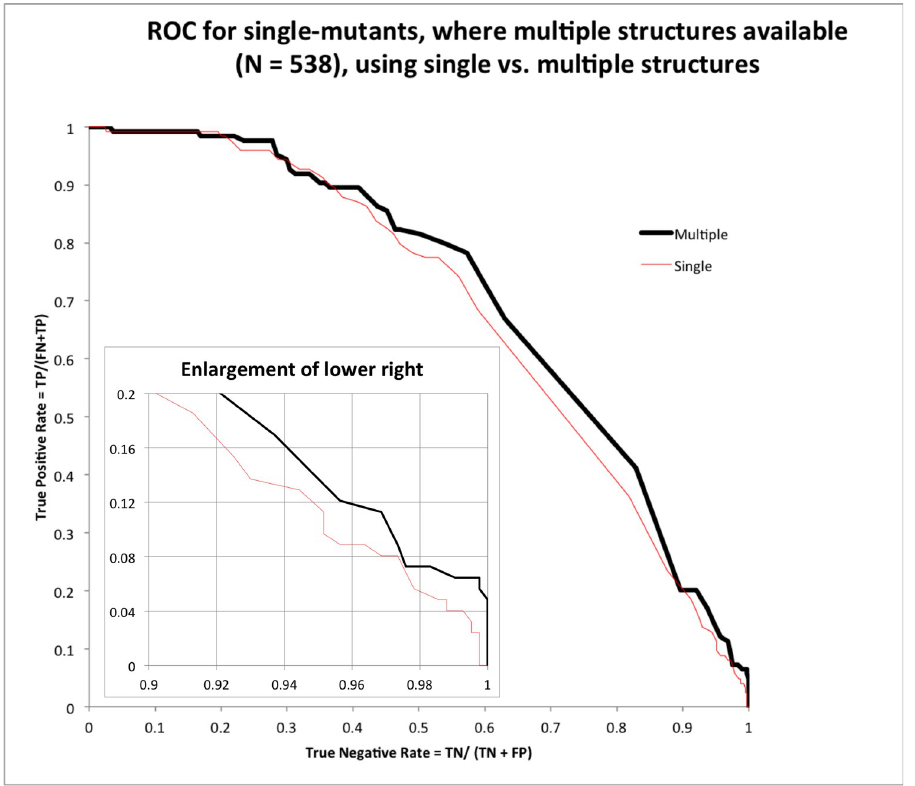
Fig 4. Receiver Operating Characteristic, comparing homologyScanner vs. calculation on single structures. Here the Test Positives are defined as mutants with ΔΔ G predicted < threshold, where the threshold is varied.